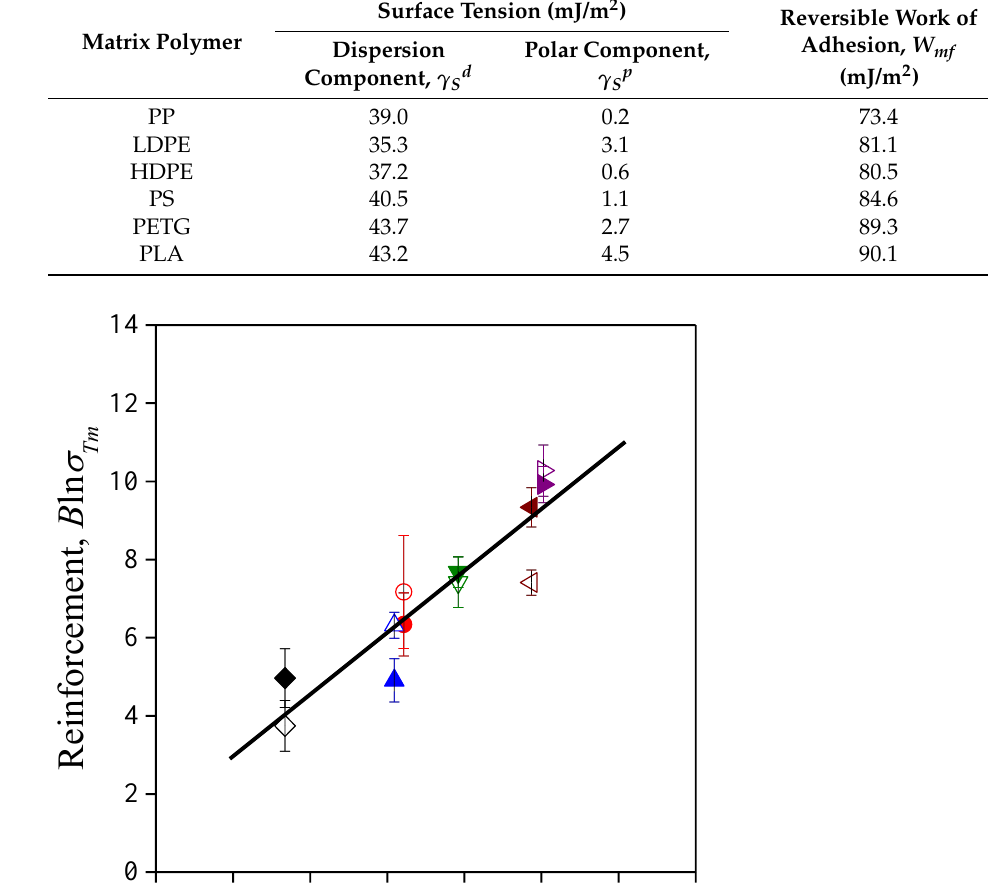
Figure 3. Physical contact between the sunflower husk particles in HDPE composites. Arrows show some physical contact points. The white scratches are the imprints of the steel mold. Filler content: 40 vol%. ( a ) SP20; ( b ) SPF.